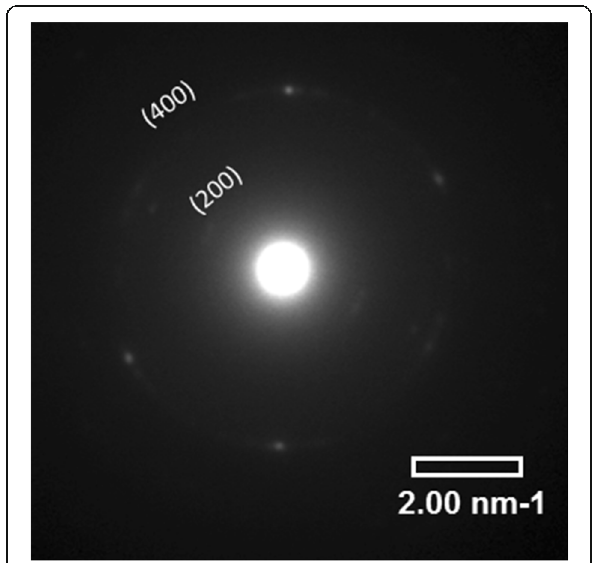
Fig. 8 SAED of a P3HT domain in P3HT-PMMA (1:50 weight ratio) blend